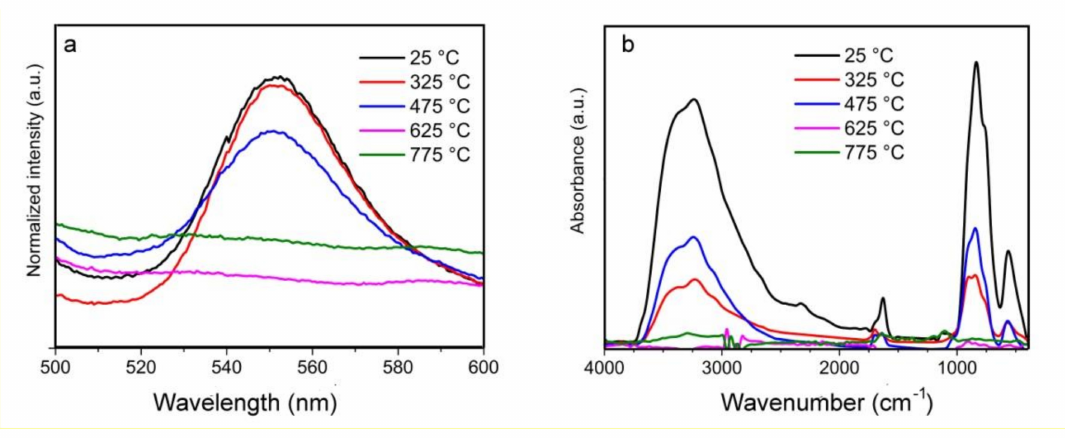
Figure 3. ( a ) Photoluminescence (PL) luminescence and ( b) Fourier transform infrared (FTIR) spectra of germanium nanoparticles prepared at di ff erent